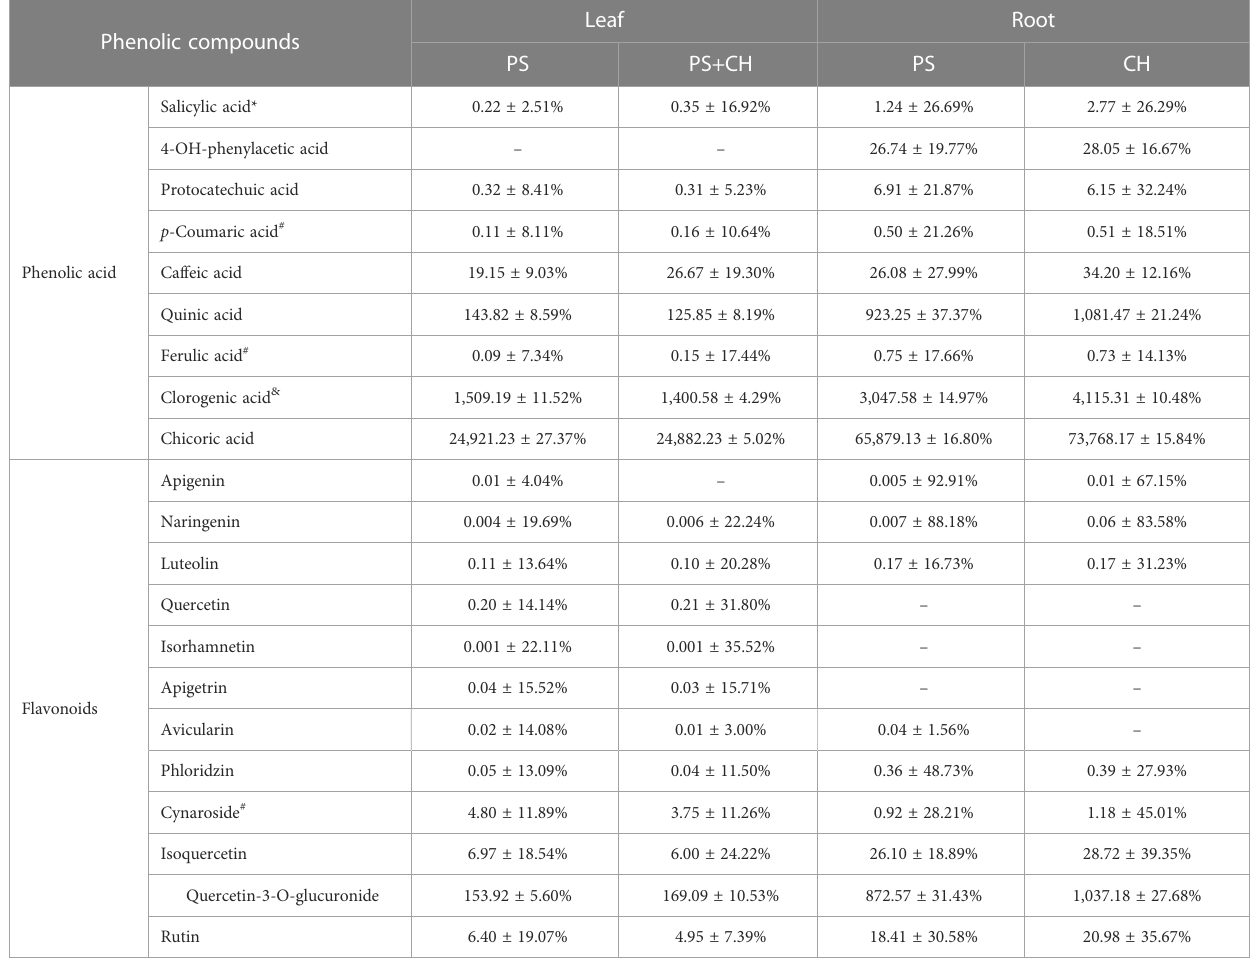
TABLE 4 Phenolic compounds (mg kg -1 ± sd %) determined using LC-MS for chitin-treated lettuce plants (PS+CH) and for untreated control plants